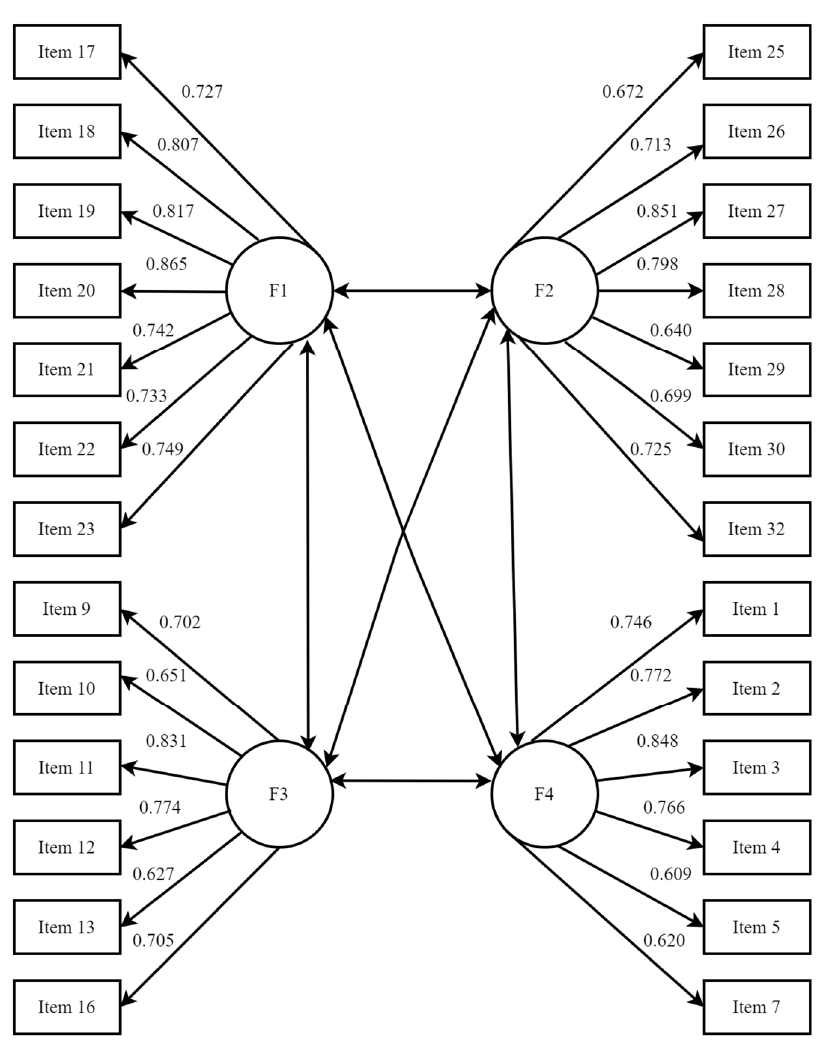
Figure 1. Confirmatory factor analysis of the four-factor model of the Mobile Phone Addiction Type Scale (MPATS).